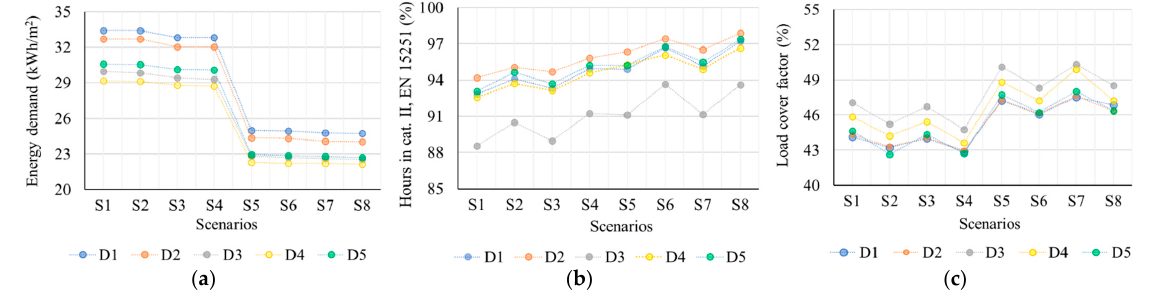
Figure 4. Results of the three performance indicators for the five analysed designs across the eight scenarios: ( a ) Energy demand results (including only heating, cooling, and lighting). ( b ) Thermal comfort results (average % of hours in cat. II of EN 15251 in five main rooms). ( c ) Load cover factor results.